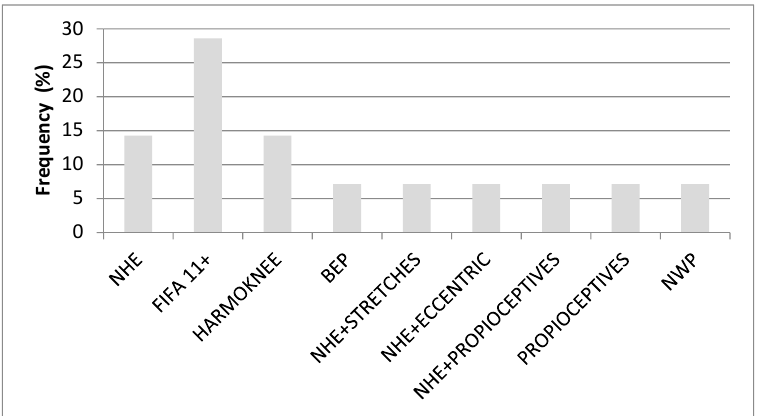
Figure 2. Frequency with which the intervention programs were employed in the selected studies. Abbreviations: NHE: Nordic Hamstring Exercise. FIFA: Federation International de Football Association. BEP: Bounding Exercise Program. NWP: New Warm-up Program.